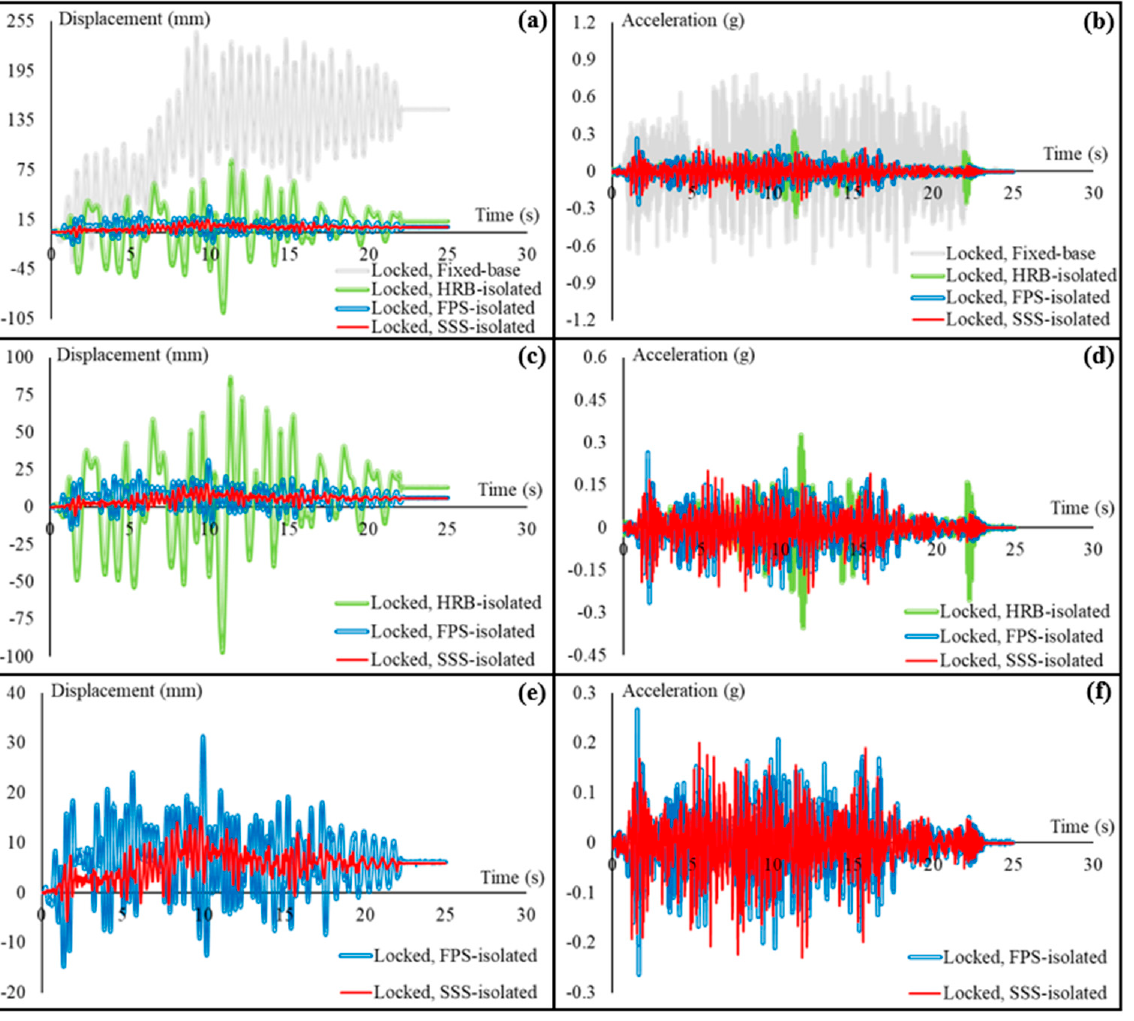
Figure 8. Seismic responses of the cart with locked wheels on the shaking table: ( a ) comparison of the displacement responses in the fixed-base and base-isolated hospital building; ( b ) comparison of the acceleration responses in the fixed-base and base-isolated building; ( c ) displacement response comparison between the isolated cases; ( d ) acceleration response comparison between the isolated cases; ( e ) SSS compared with FPS (as the other sliding IS), in terms of the recorded displacement response of the cart; and ( f ) SSS compared with FPS, in terms of the acceleration response.